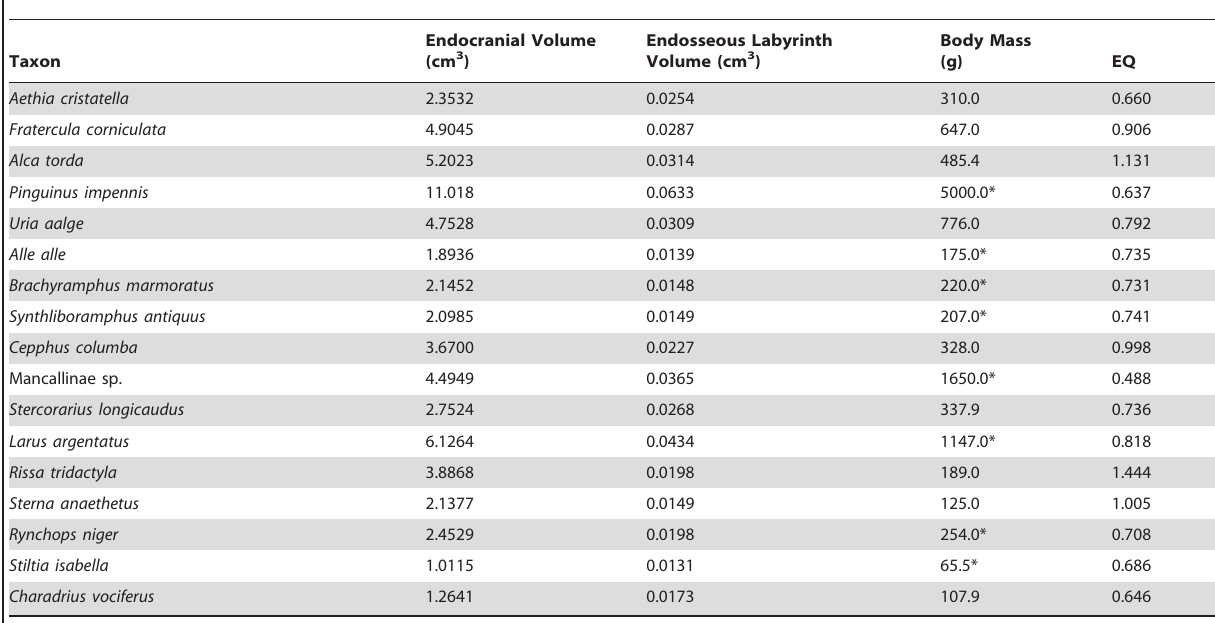
Table 3. Endocranial volume, endosseous labyrinth volume, body mass and encephalization quotients (EQ) of sampled charadriiform